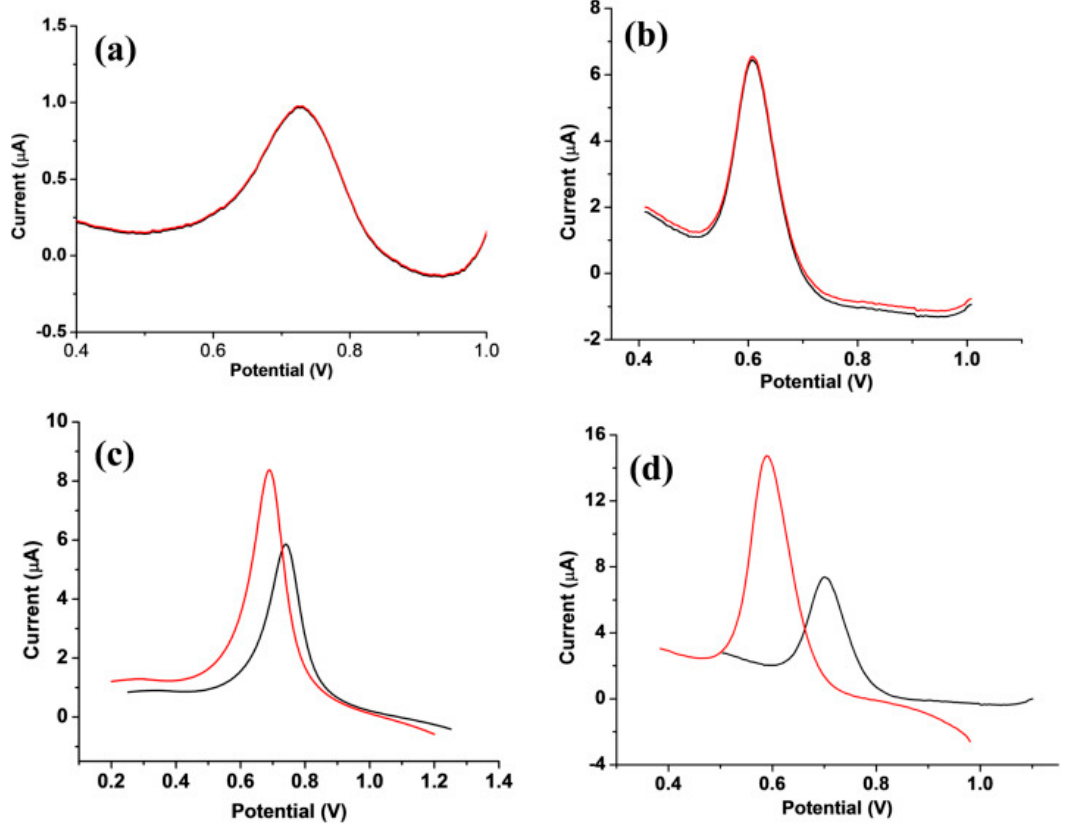
Figure 10. DPV responses of ( a ) bare GCE, ( b ) RGO / GCE, ( c ) β -CD / GCE and ( d ) β -CD / RGO / GCE in the presence of L-Phe, (red) and D-Phe (black) in 0.1 M PBS (pH 7.0) at scan rate of 100 mV × s − 1 . Reprinted from [68] with permission of publisher.